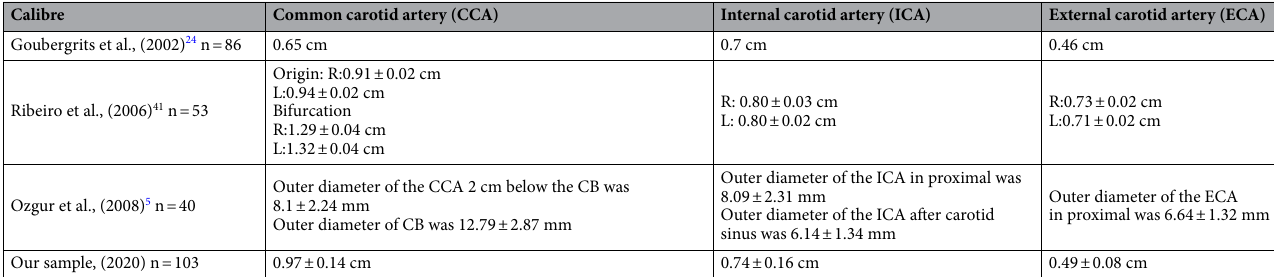
Table 1. Diameter of the carotid arteries. A comparison of our results and those other authors. N sample size, CCA Common carotid artery, ICA internal carotid artery, ECA external carotid artery, CB Carotid bifurcation, M male, F